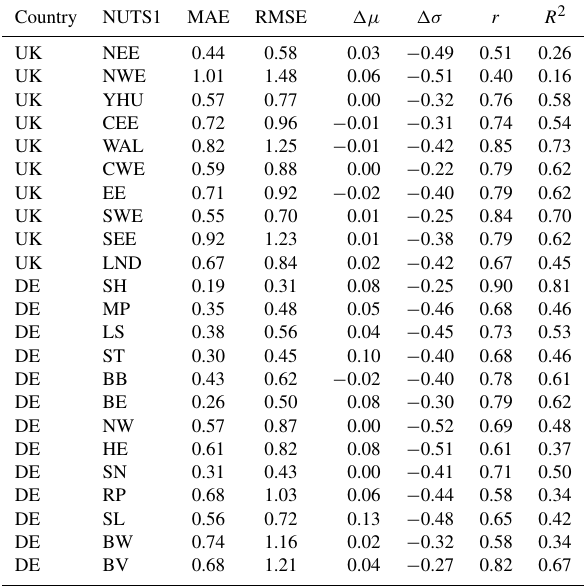
Table 2. Model performance metrics of cross-validated random for- est models per NUTS1 region.